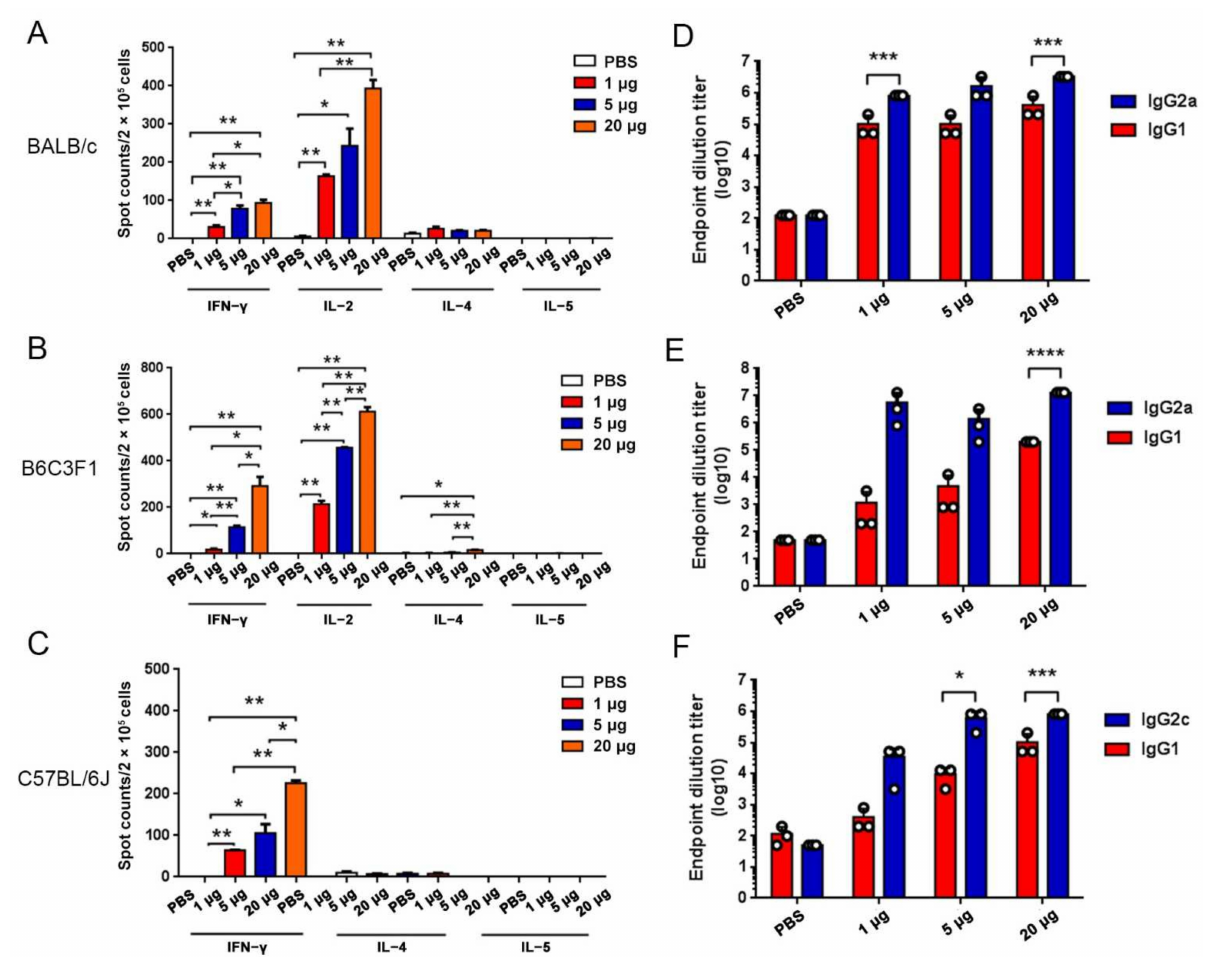
Figure 3. RBMRNA-176 immunization induced Th1-skewed immune responses in mice. BALB/c, B6C3F1 and C57BL/6J mice were vaccinated with two shots of RBMRNA-176 (1, 5, or 20 µ g) at